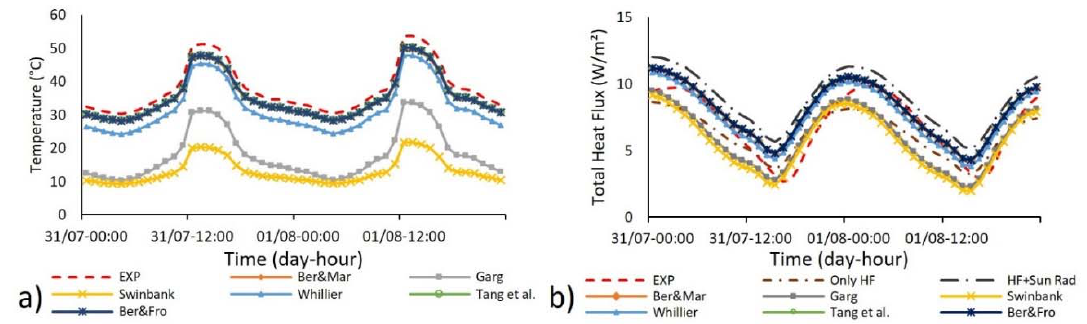
Figure 13. Two days result shows the impact of longwave radiation on the FE model’s ( a ) external